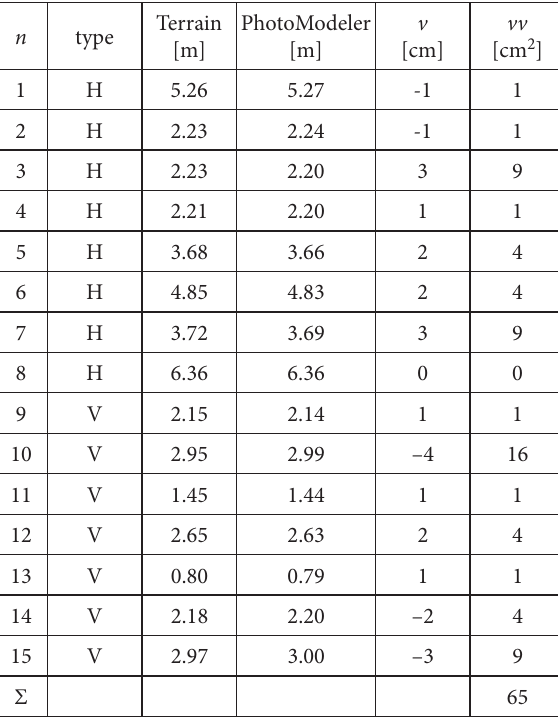
Table 1. Accuracy evaluation of the 3D model n